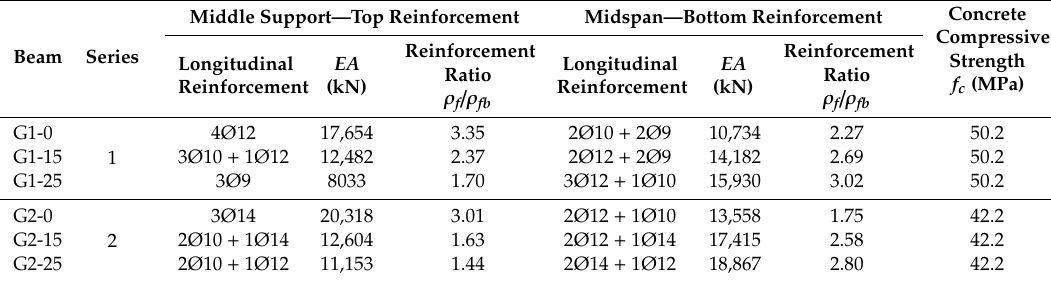
Table 1. Reinforcement details and concrete compressive strength for tested beams.